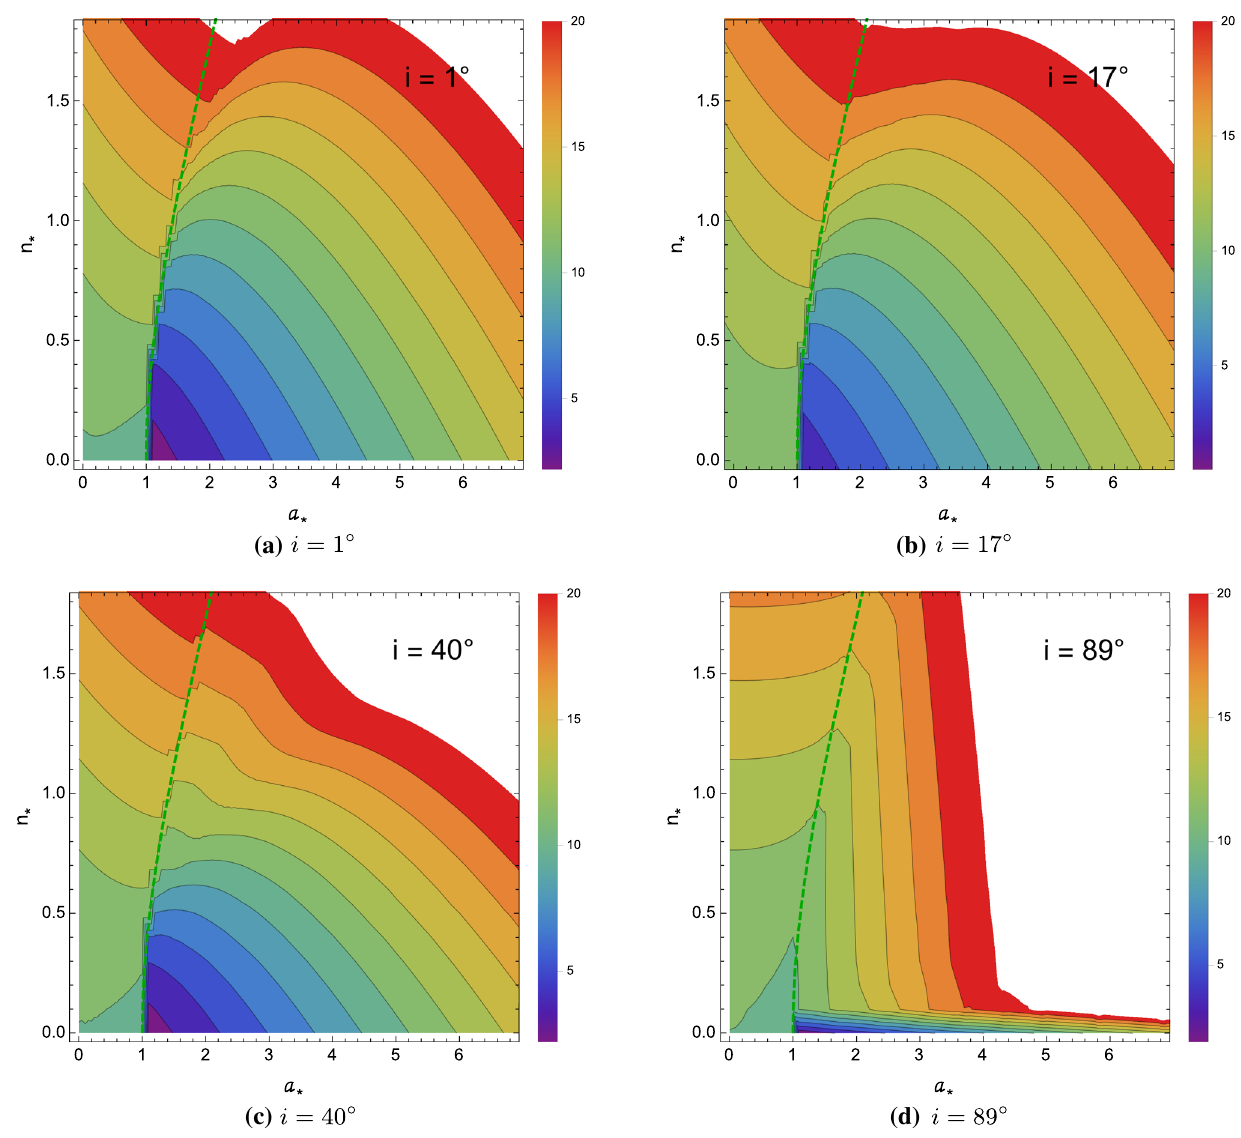
Fig. 2 Dependence of the shadow radius ¯ R (in unit of ‘ M ’) on the Kerr and NUT parameters of a KTN collapsed object, for four dif- ferent inclination angles ( i ) . Variation of these theoretically predicted shadow sizes are indicated by the rainbow colors. The green dashed line Sects. 3.1 and 3.2 represents the division between the KTN BHs (left)